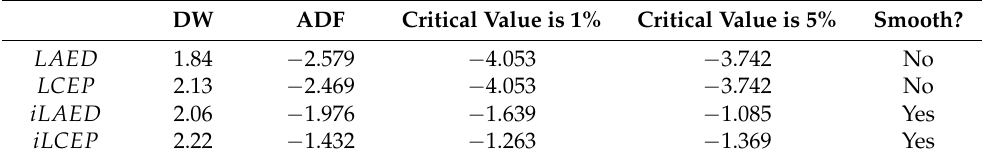
Table 3. The result of ADF unit root test. DW ADF Critical Value is 1% Critical Value is 5% Smooth?